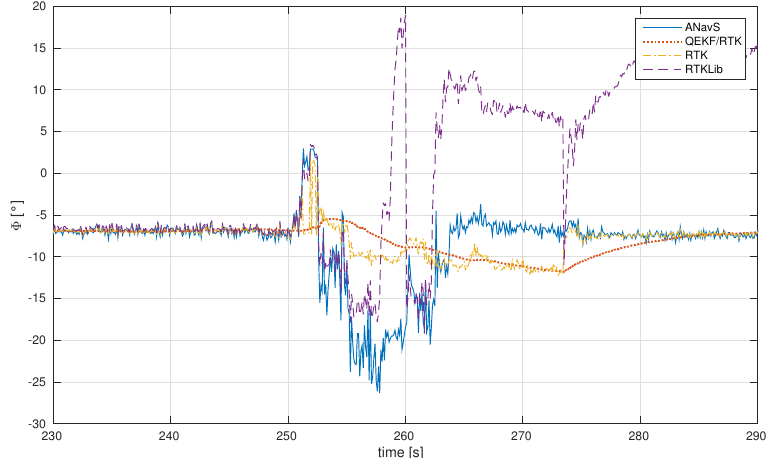
Figure 6. Temporary loss of the lock of two satellites: The reference system from ANavS, the proposed method and its GPS heading measurements and the GPS heading acquired from the RTKLIB using its standard settings for a moving